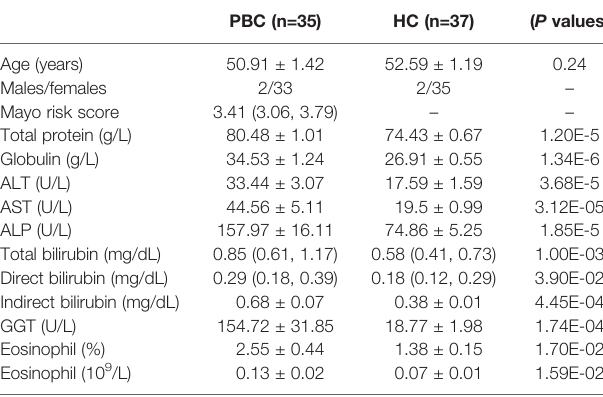
TABLE 1 | Clinical features of PBC patients and HCs in this